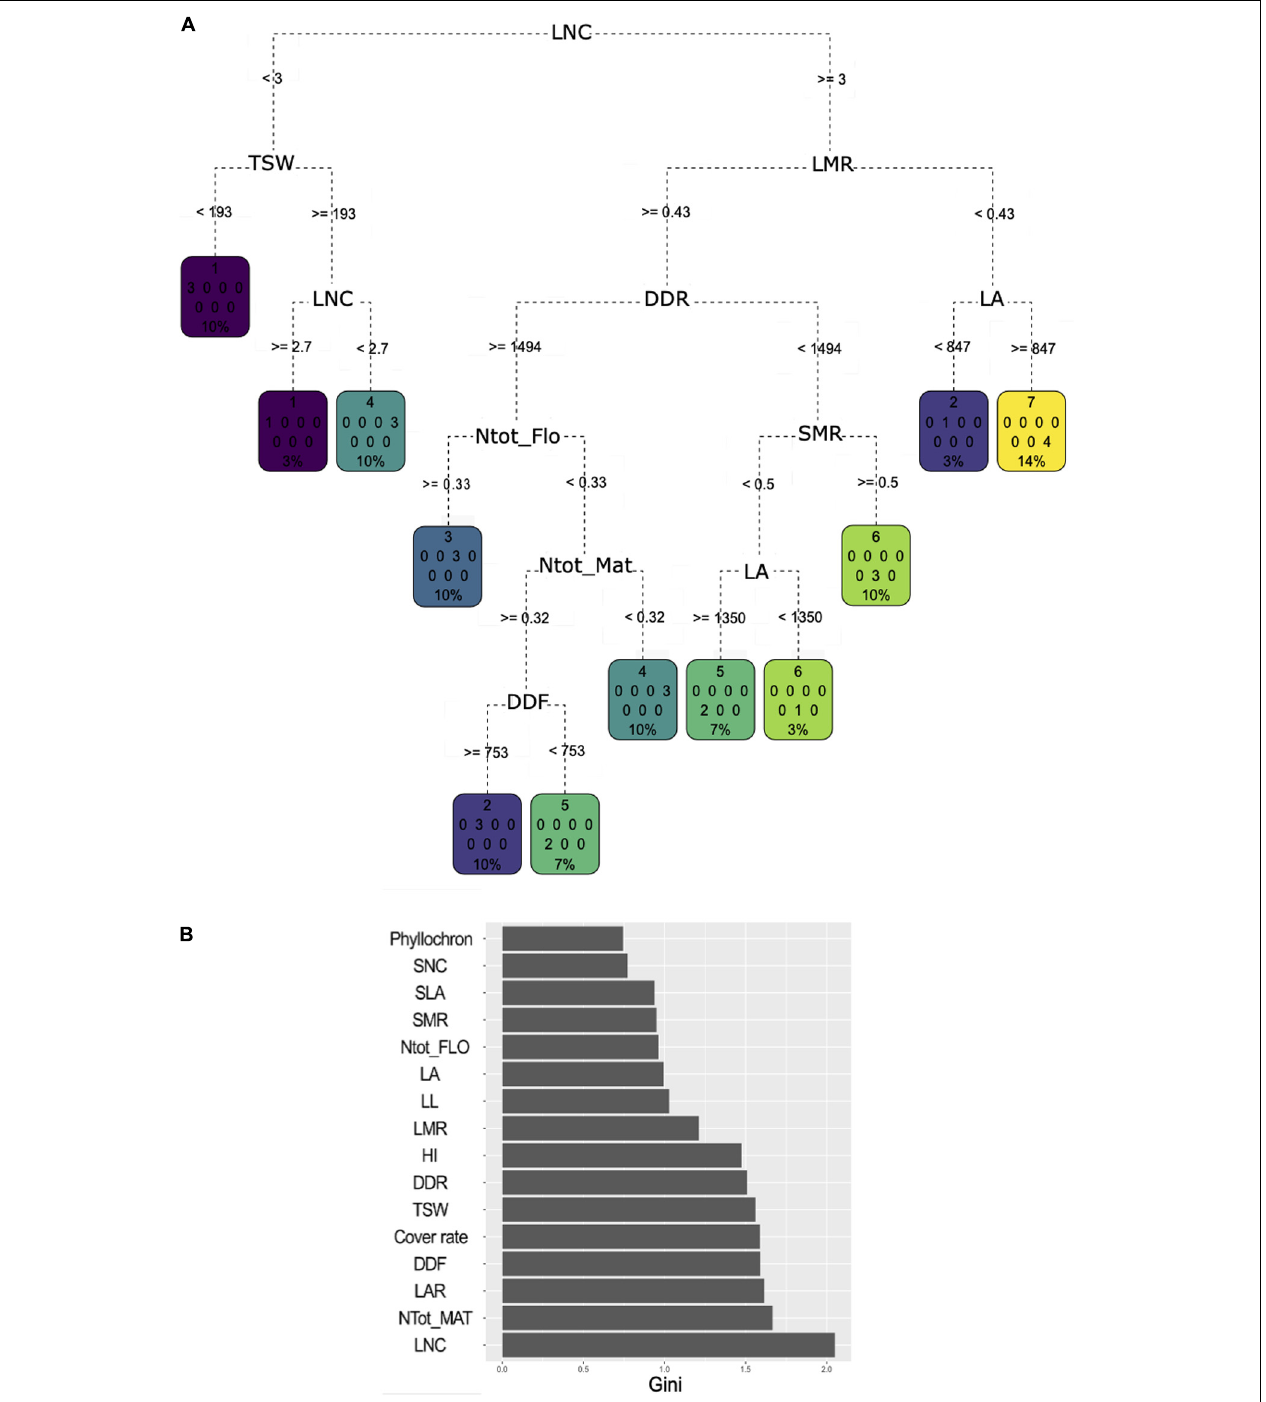
FIGURE 4 | (A) Classification and regression tree (CART) regression for prediction of membership to one of the seven clusters based a hierarchical clustering analysis of the 30 pulse varieties based on agroecosystem properties (see Figure 3 ). Root nodes represent single input variables (traits) and related split point used to make the prediction; the best discriminant is chosen at each step of the classification procedure. Leaf nodes contain mean, number, and percentage of observations of the predicted variable (cluster membership). (B) Gini decrease value for each trait obtained through a random forest procedure. A high Gini decrease value means the variable considered allowed to gain purity in the process of classification for most of the nodes in the CART it was associated with during the random forest procedure.